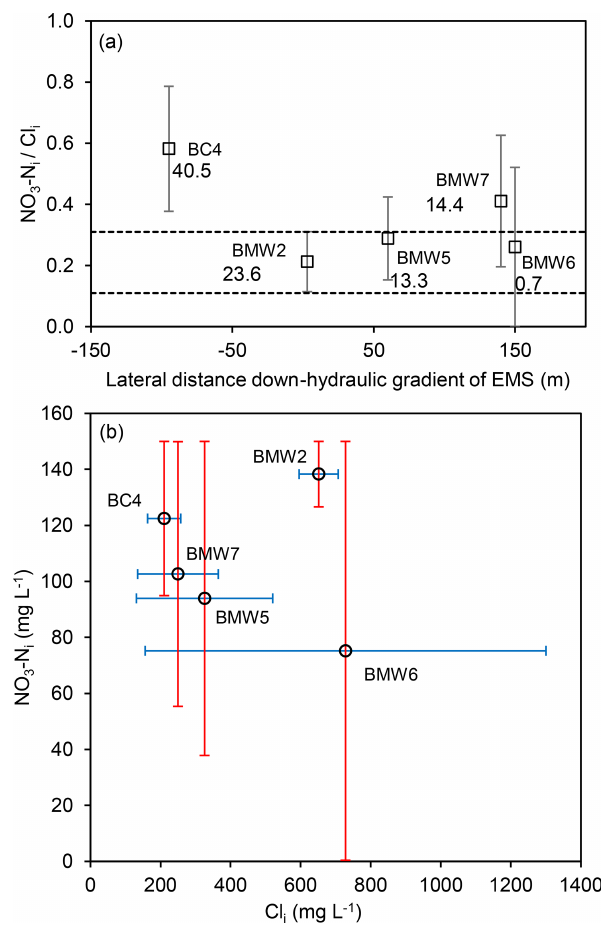
Figure 6. (a) Estimated NO 3 − N i / Cl i ratios (mean and SD) in wa- ter table wells with evidence of denitrification at CFO4, plotted with distance from earthen manure storage (EMS), where dashed lines are upper and lower bounds of BMW2 (EMS source) and values are maximum measured NO 3 − N (mgL − 1 ). (b) Estimated concen- trations of NO 3 − N i and Cl i at CFO4 (mid-range, error bars are max and min